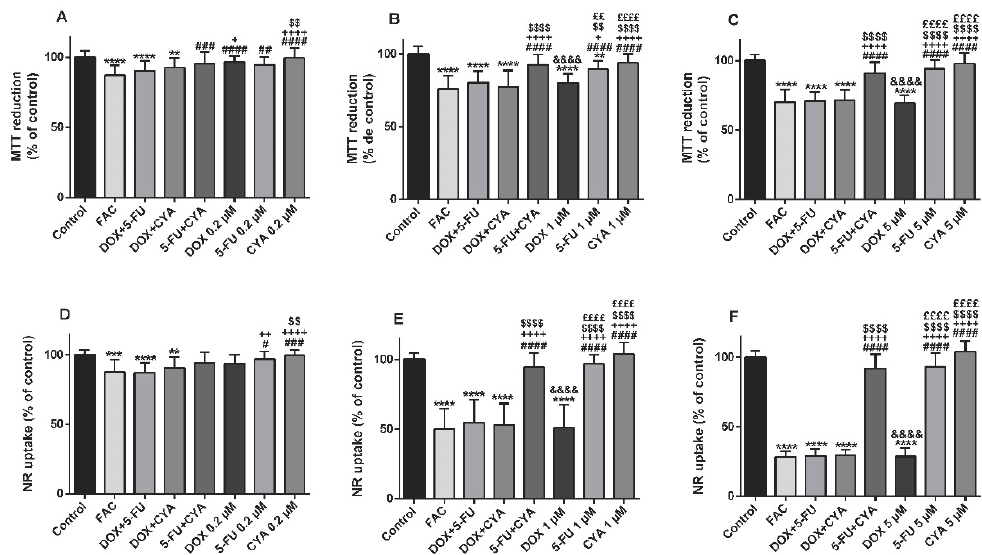
Figure 4. Mitochondrial and lysosomal dysfunction evaluated by the MTT reduction assay ( A – C ) and the NR uptake assay ( D – F ), respectively, in differentiated H9c2 cells incubated with 0.2 ( A , D ), 1 ( B , E ) or 5 μ M ( C , F ) of 5-Fluorouracil + Adriamycin + Cyclophosphamide (FAC), other mixtures of DOX, 5-FU and CYA and the drugs alone for 48 h. Results are presented as mean ± SD of 4–9 independent